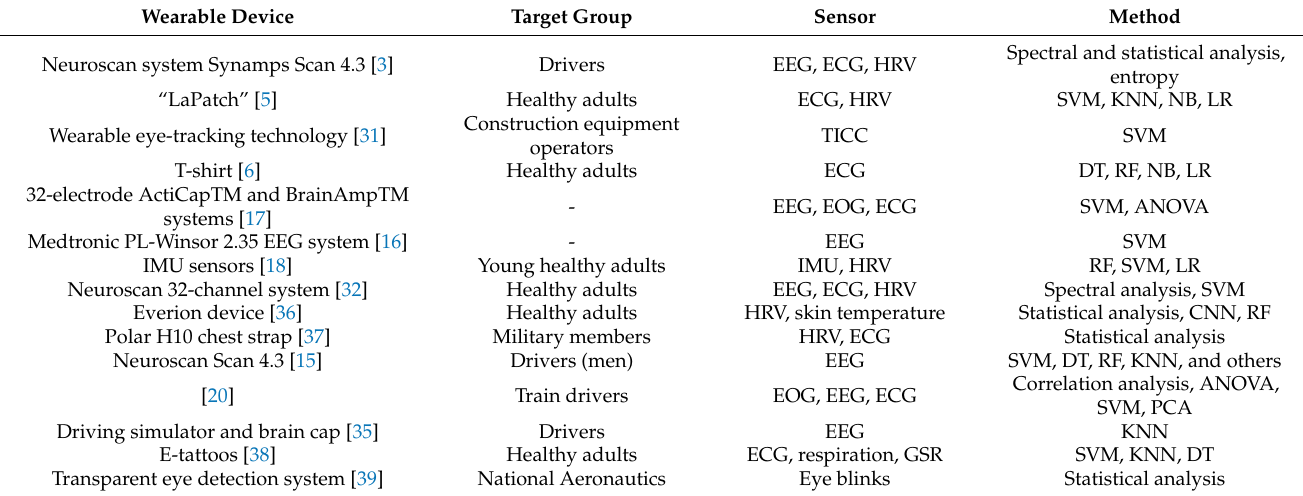
Table 1. Wearable devices used to detect mental fatigue in recent